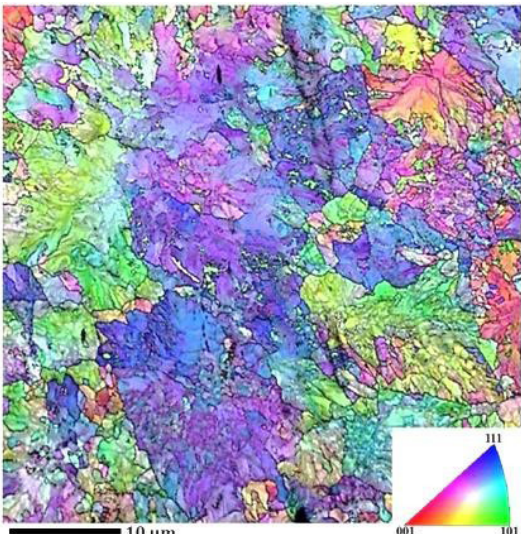
Figure 5. Transverse direction IPF of sample isothermally transformed at 700°C.